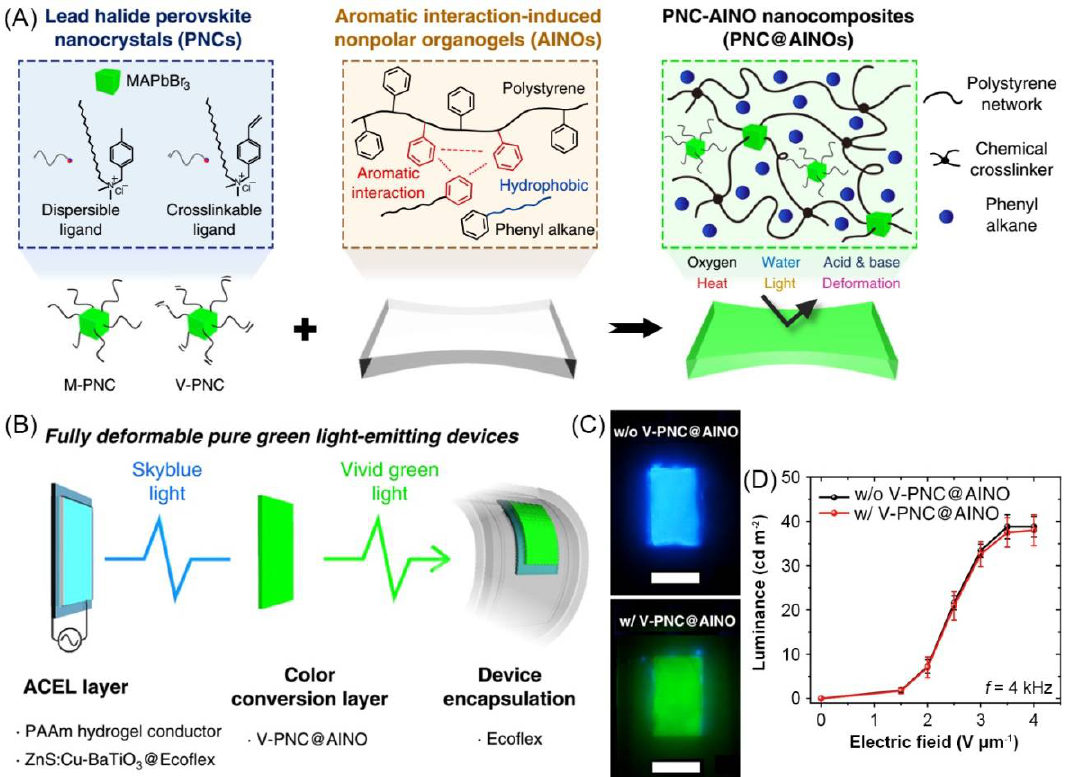
Figure 4. ( A ) Schematic of structure of green luminescent perovskite nanocomposite gel. ( B ) Schematic of design of the organogel/Ecoflex/organogel composite-based light-emitting device. ( C ) Photographs of emission color from ACEL layer without (upper) and with V-PNC@AINO layer (lower). Scale bar = 1 cm. ( D ) Applied AC electric field dependence of Luminance of devices without and with V-PNC@AINO layer. Adapted under terms of Creative Commons Attribution